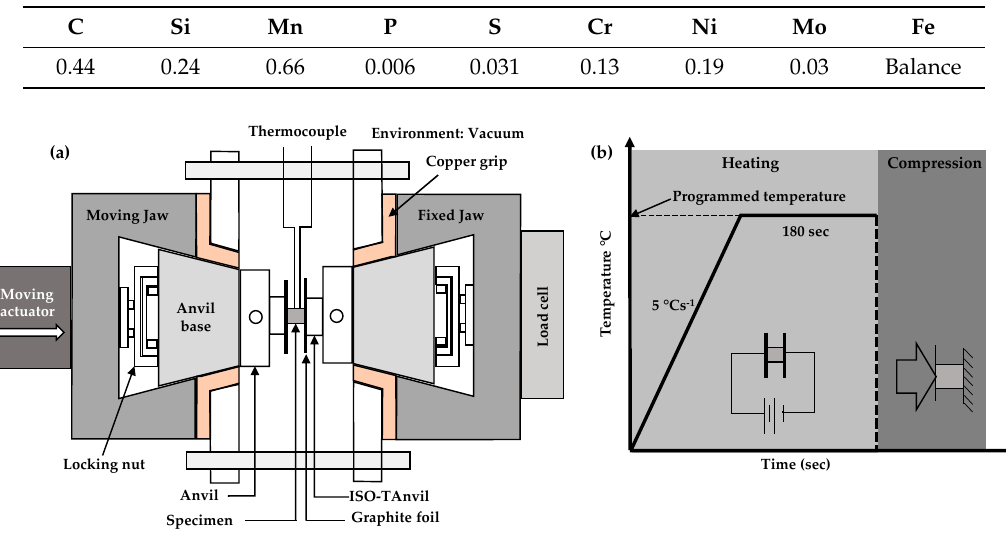
Figure 1. ( a ) Schematic of the Gleeble hot compression testing setup with thermocouples welded to the specimen; ( b ) heating and compression cycle used in the study.